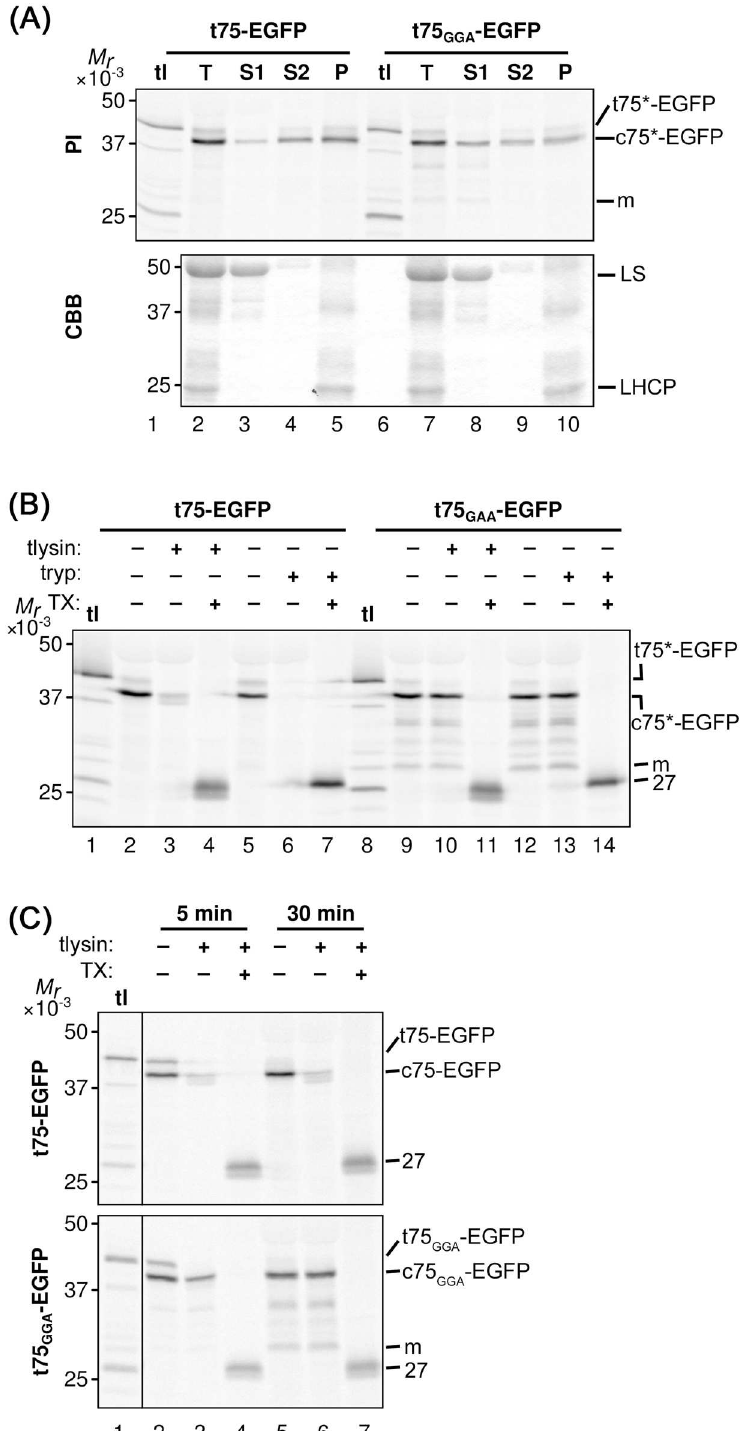
Fig 3. In vitro import of t75-EGFP variants. (A) Import of radiolabeled t75-EGFP variants into isolated chloroplasts, post-import fractionation, and analysisof the results were done as describedin Fig 2A. The experiments were done concurrently with those shown in Fig 2A and S1 Fig. The precursor proteins containing the entire t75 variants, the intermediates containing the c75 variants but not n75, and the mature form that lacks the entire t75 variants are indicatedas t75 * -EGFP, c75 * -EGFP, and m, respectively. For